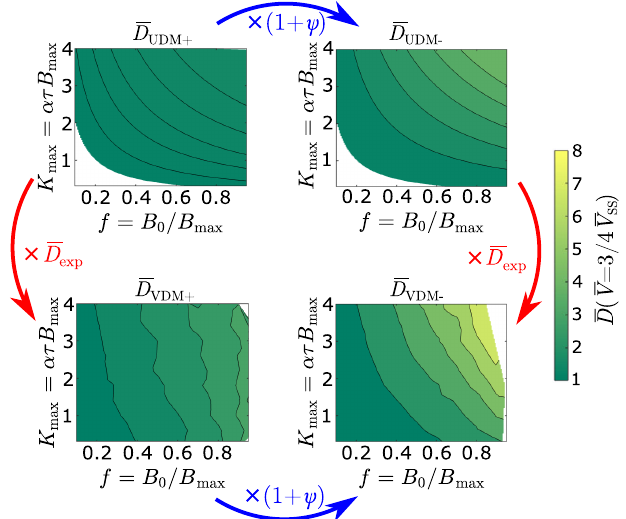
FIG. 5. Dimensionless diffusion coefficients in each of the models determined at the front position where the phage ¯ V population is 3 = 4 times the steady-state population plotted SS as a function of both f and K . Contour lines indicate levels of max ¯ D constant . The behavior of the contours qualitatively matches that of the transition boundaries in Fig.